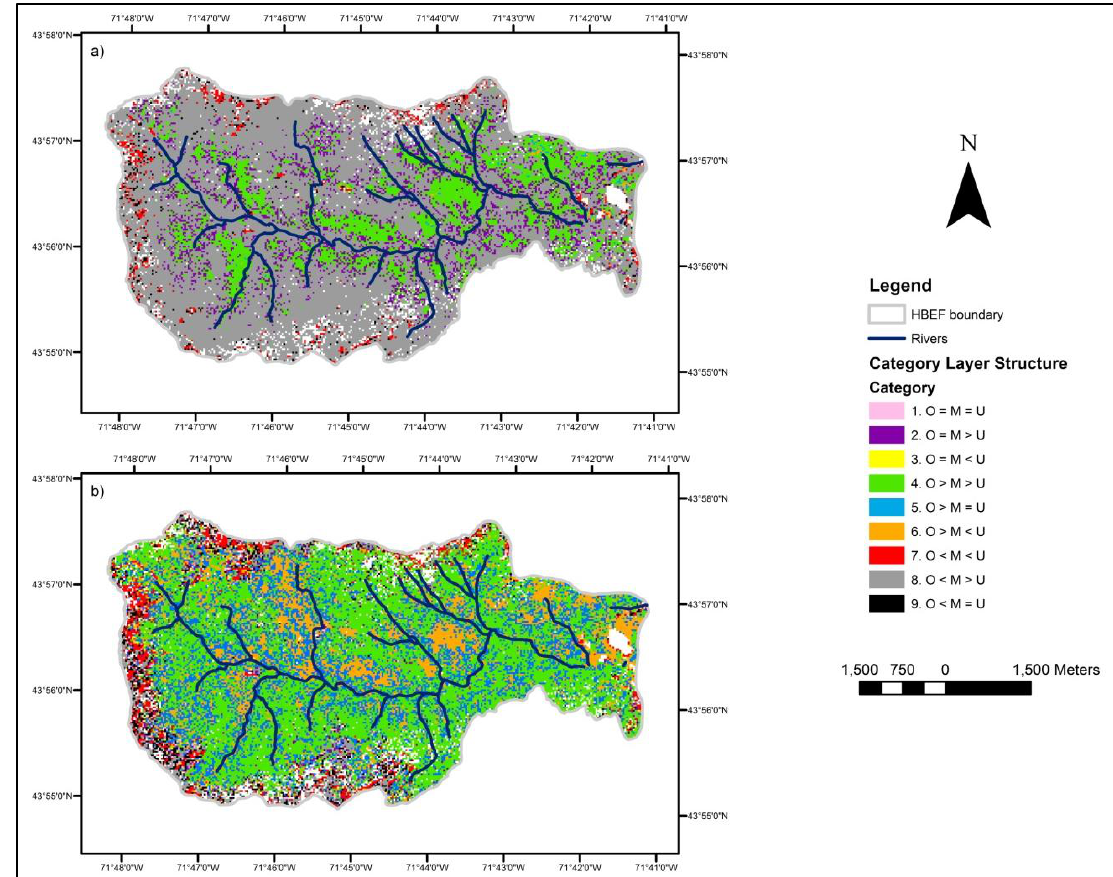
Figure 14. Maps of canopy layer structure categories in HBEF using two different height intervals. ( a ) shows layer heights as 0 to 5 m (understory), 5 to 15 m (midstory) and 15 m to canopy top (overstory); ( b ) shows layer heights as 0 to 5 m (understory), 5 to 10 m (midstory) and 10 m to canopy top (overstory).